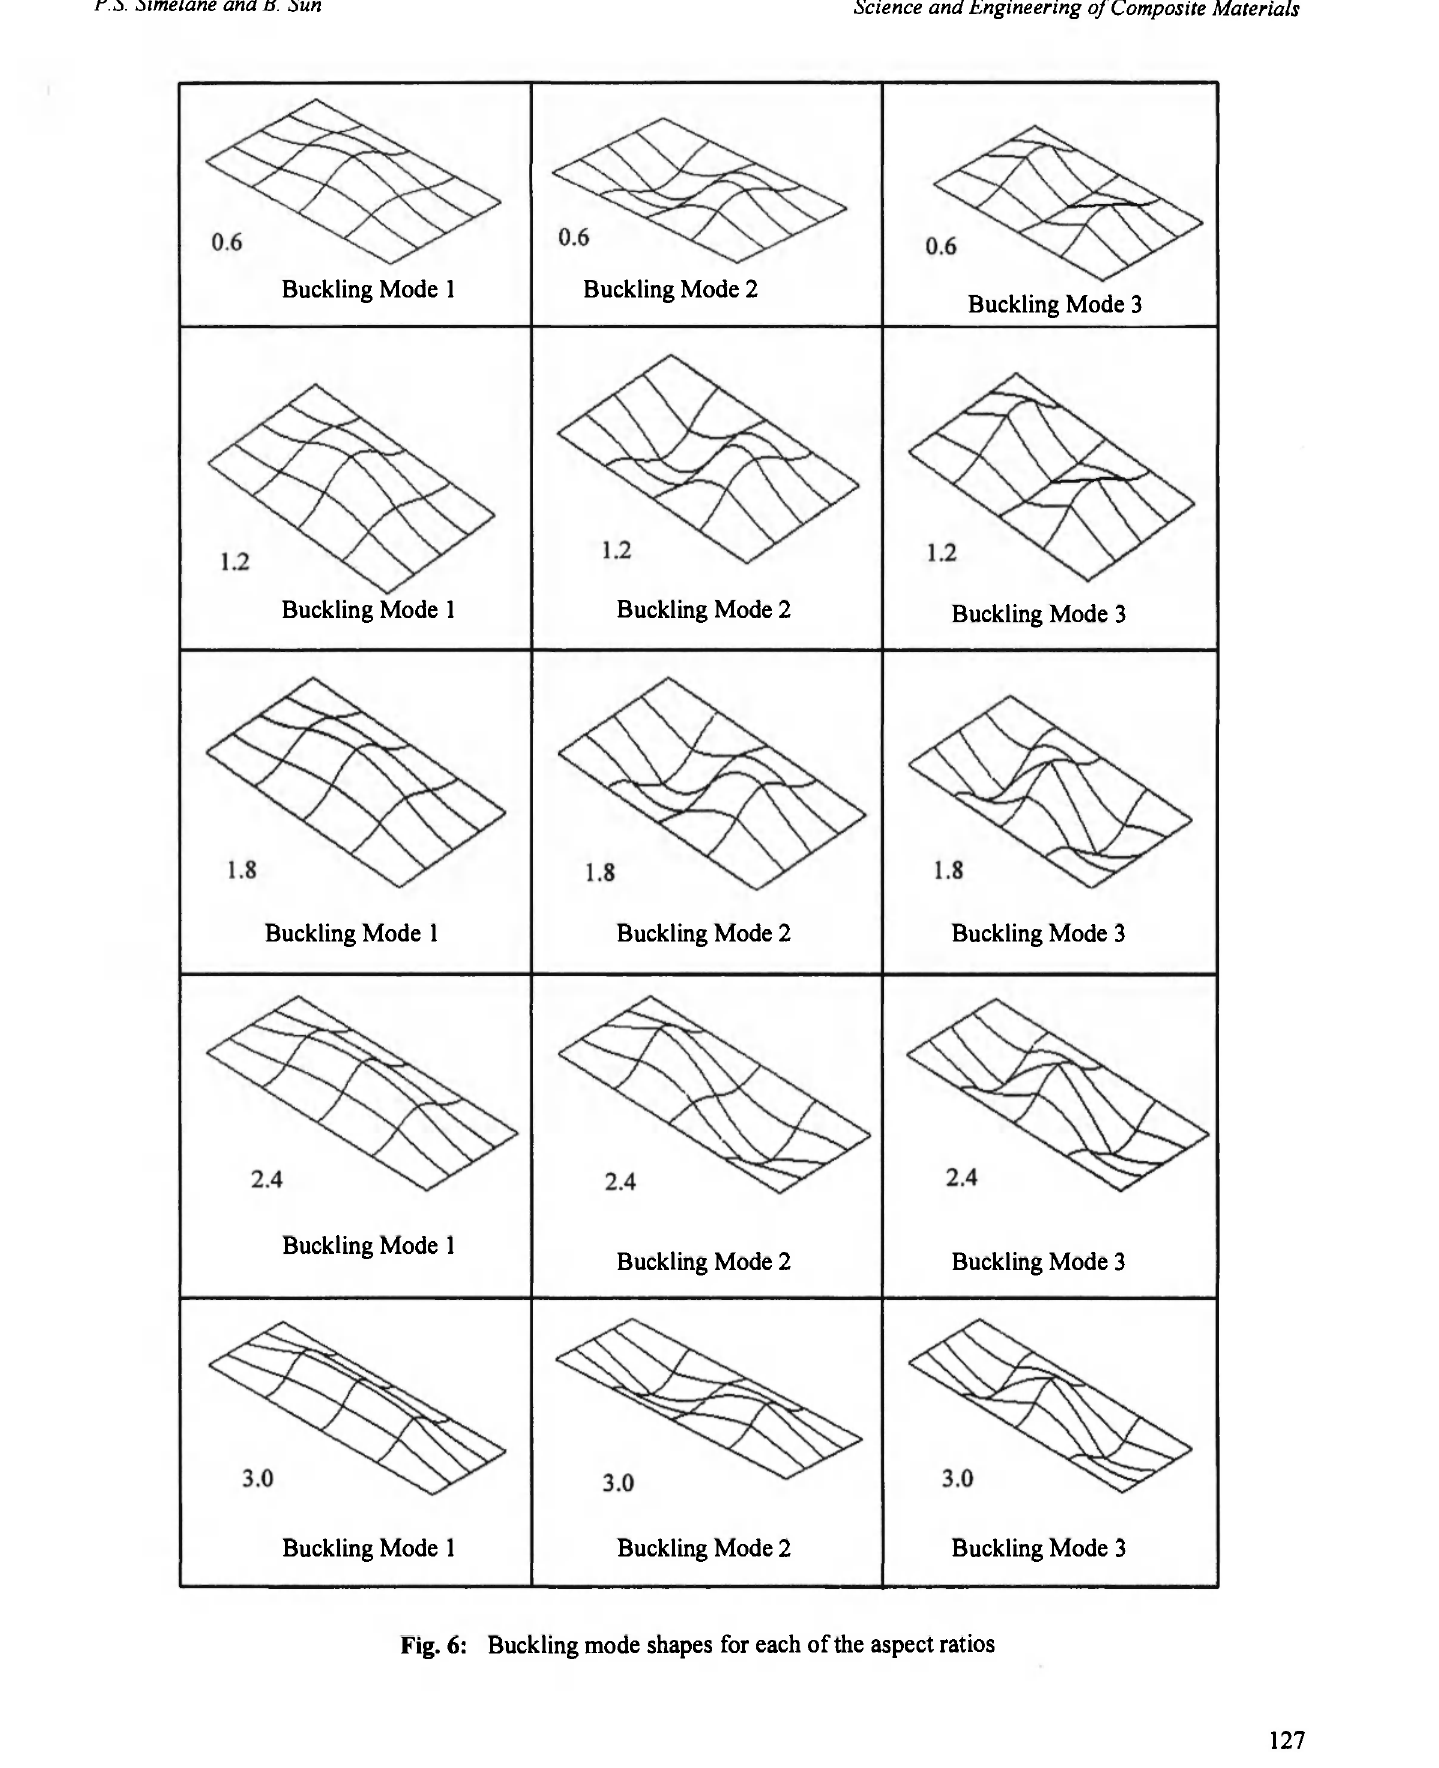
Fig. 6: Buckling mode shapes for each of the aspect